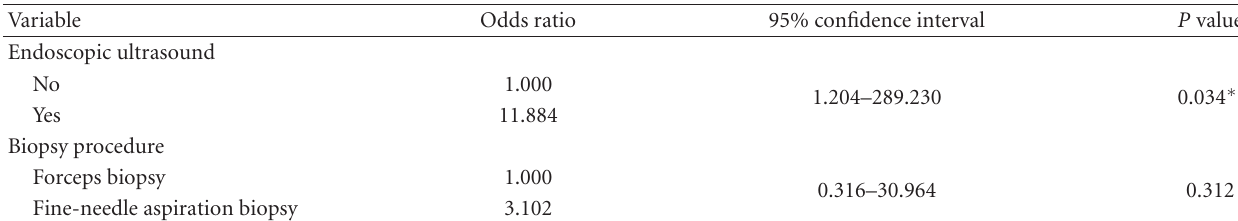
Table 3: Multivariate